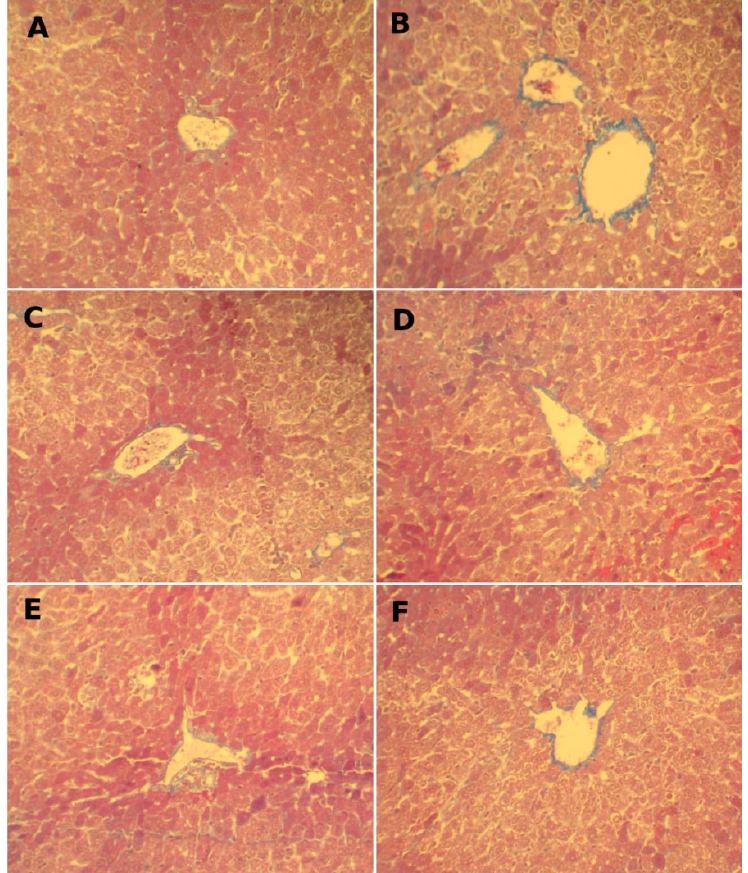
Figure 2. Effect of FLE and DLE on hepatic connective tissue fibrosis caused by CCl 4 treatment : assessment by Masson’s trichrome stain (G × 200). ( A ) Control, ( B ) CCl 4 -treated, blue-stained zone indicates increasing fibrosis. ( C ) FLE-treated (30 mg/kg), and ( D ) co-treated with CCl 4 and FLE (30 mg/kg); ( E ) DLE-treated (30 mg/kg) showing normal structure and ( F ) co-treated with CCl 4 and DLE (30 mg/kg) showing results close to the control.